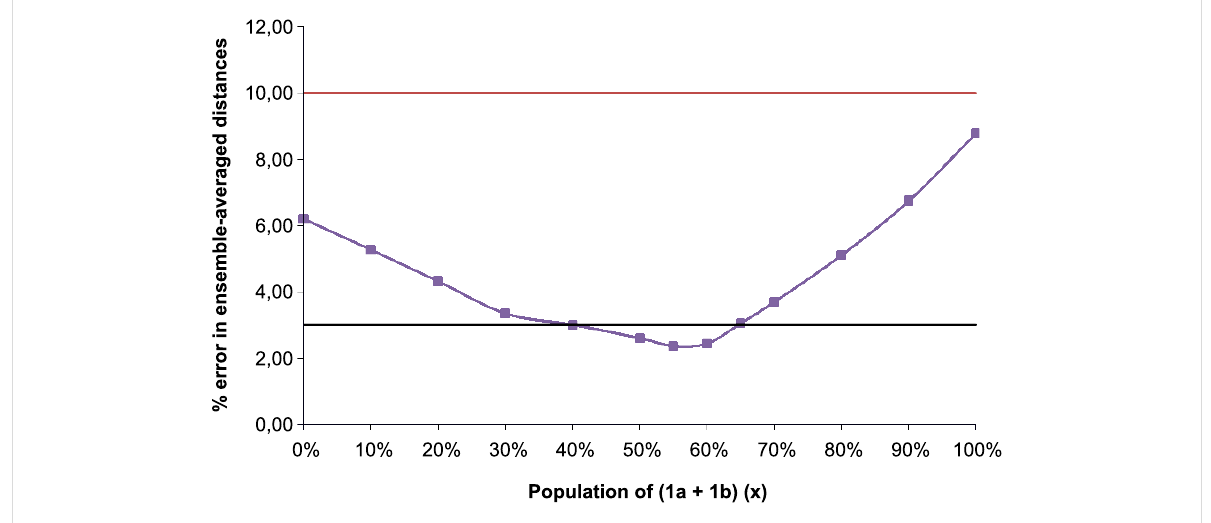
Figure 2: Plot of the mean calculated error arising from fitting the population distribution of conformers 1a/b ( x ) and 2a/b (1 − x ) to the experimental NOE-derived interproton distances. Exemplar error thresholds are represented at 3% (black line) and 10% (red line).